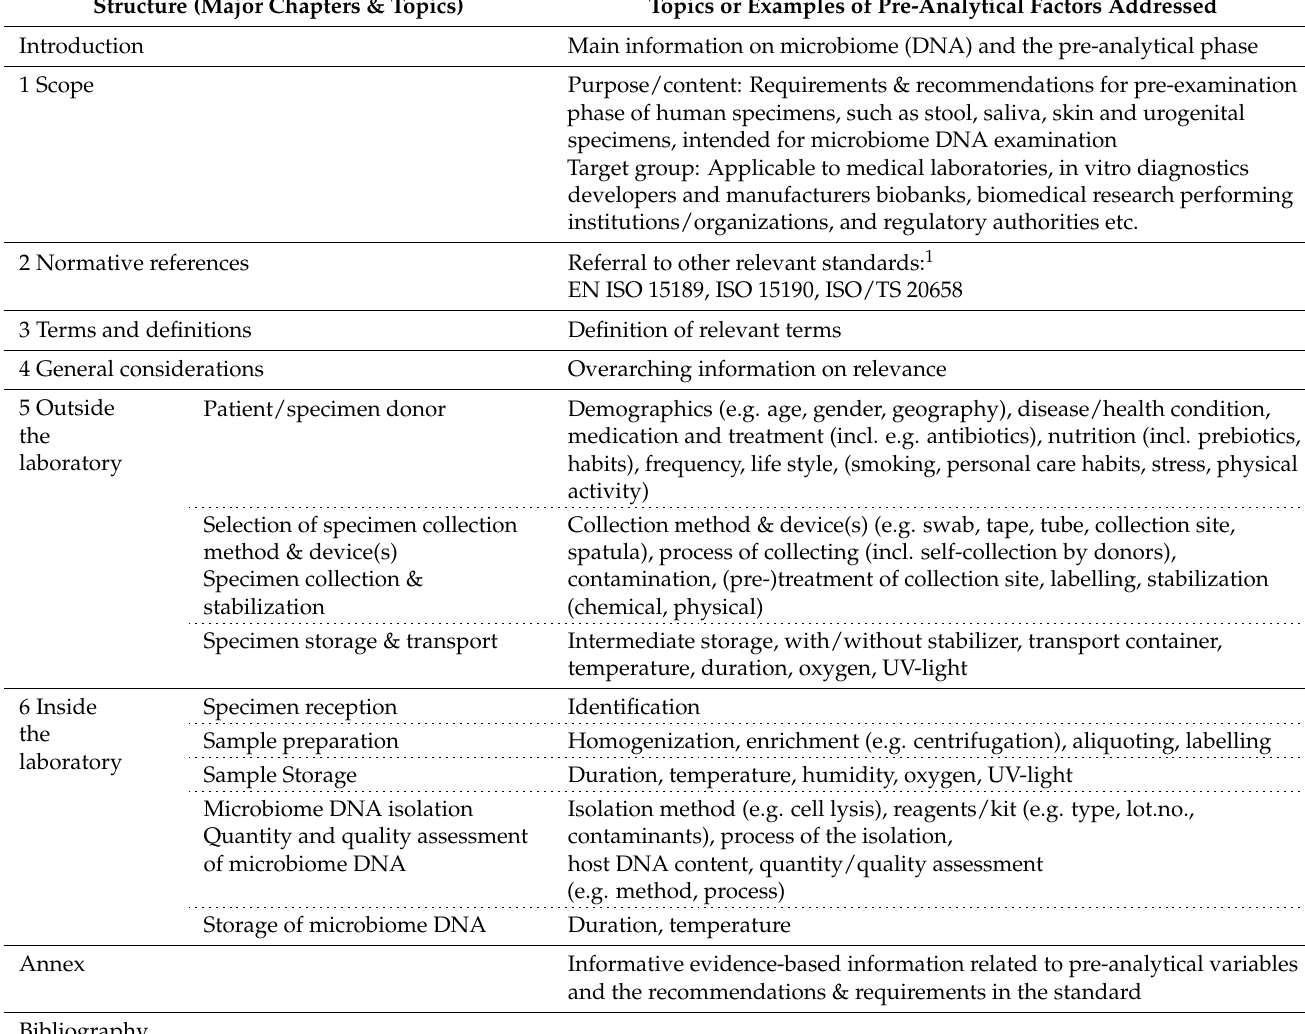
Table 3. Structure of pre-analytical standards (based on CEN/TS